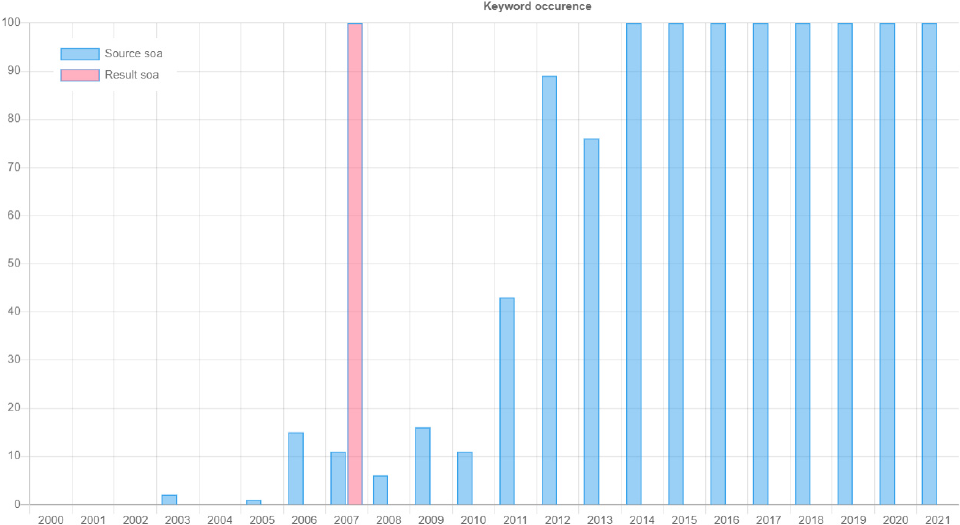
Figure 9. Occurrence SOA in paper abstracts (blue) and in the reference (in red). Note the scale is clipped at 100 to ensure the initial occurrences are identified.